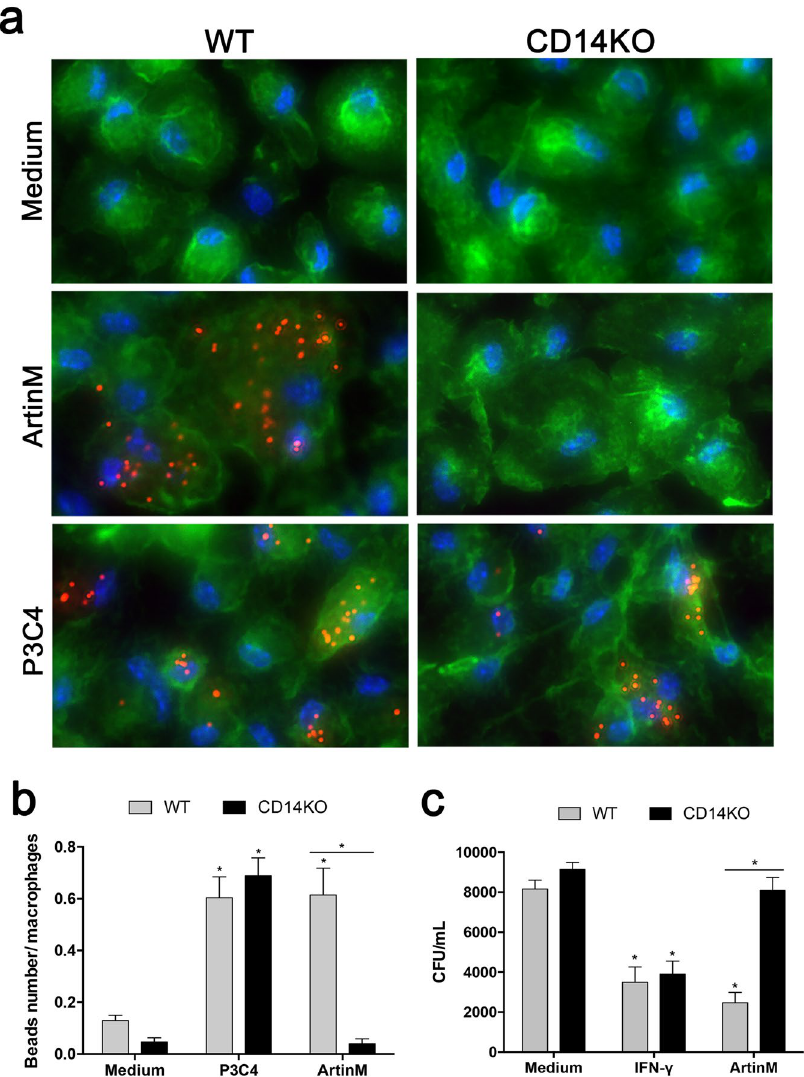
Figure 4. Phagocytic and fungicide activity of ArtinM-stimulated macrophages depends on CD14. ( a and b ) Phagocytic activity was realized in macrophages (5 × 10 5 /well) from the WT and CD14 KO mice after stimulation with ArtinM (2.5 µ g/mL), P3C4 (1 µ g/mL), or medium for 16 h. The cells were then incubated with phycoerythrin-conjugated latex beads (red) for 30 min, stained with phalloidin-fluorescein isothiocyanate (green) and 4 ʹ ,6-diamidino-2-phenylindole (blue), and processed for fluoresce microscopy ( a ). The images were acquired on a fluorescence microscope at 40 × magnification and were used to measure the number of beads internalized per macrophage from the WT (gray bar) and CD14KO (black bar) mice. The mean number of beads/macrophage was plotted ( b ). ( c ) The fungicide activity assay was carried out in macrophages (1 × 10 6 /mL) from the WT and CD14KO mice after stimulation with ArtinM (2.5 µ g/mL), IFN- γ (50 ng/ mL), or medium. After 24 h, the macrophages were infected with P. brasiliensis (yeast-to-macrophage ratio of 1:10), for 4 h. The non-internalized yeasts were removed and the medium was added to the cells, which were cultured for an additional 48 h. The macrophages were lysed with distillated water for the measurement of viable intracellular yeasts by CFU. ( a – c ) The phagocytic and fungicide activity in the WT and CD14 KO macrophages were compared with those of cells in medium, and the values were also compared between the WT and CD14 KO macrophages stimulated with ArtinM, P3C4, or IFN- γ . The data are shown as means ± SEM of independent experiments. * p < 0.05, according to one-way analysis of variance and Bonferroni’s